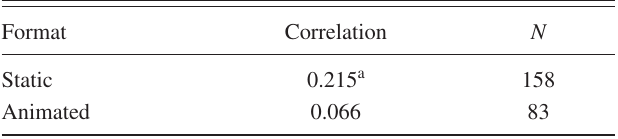
TABLE II. Correlation coefficients between English ACT score and FCI scores.